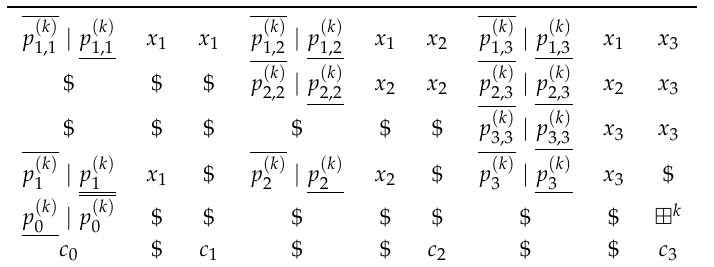
( k ) p x i + p i = 1 i